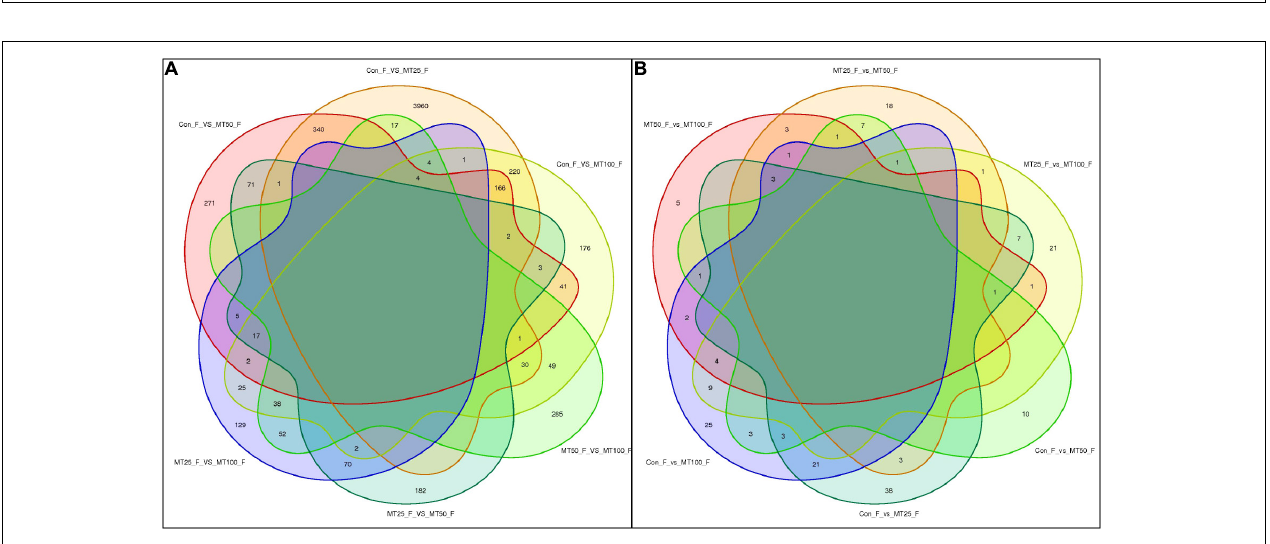
FIGURE 2 | Venn diagram analysis of differentially expressed genes (DEGs). (A) DE miRNAs miRNA (DEMs). (B) In rare minnow ovaries after MT (25, 50, and 100 ng/L) treatment.